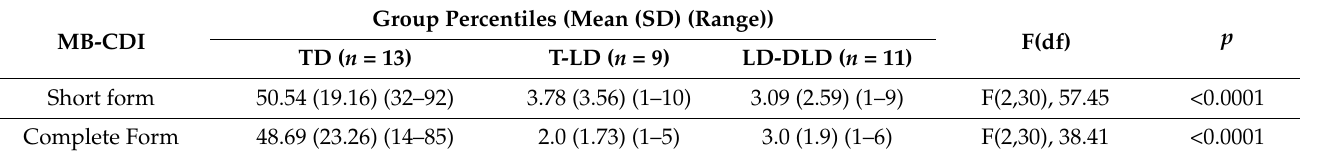
Table 2. Percentiles for the Italian version of the Words and Sentences MB-CDI short form and complete